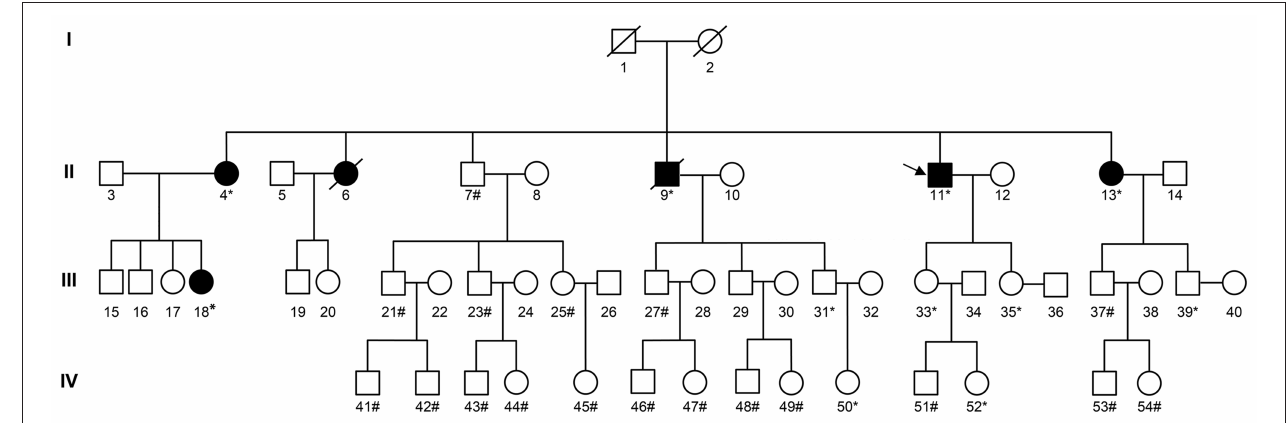
FIGURE 4 | Pedigree of the family with MSH2 c.1024_1026. The arrow ( → ) indicates the proband. Squares and circles denote males and females, respectively. Roman numerals indicate generations. Black solids represent tumor patients. Patients number 4, 6, 13, and 18 suffered from endometrial carcinoma before the age of 50. Furthermore, patient number 4 also suffered from rectal carcinoma at the age of 52. Patient number 9 suffered from gastric carcinoma at the age of 60. Patient number 11 suffered from renal carcinoma at the age of 41, skin carcinoma at the age of 53, and a rectal neuroendocrine tumor at the age of 58. The asterisk (*) indicates MSH2 c.1024_1026 carriers. The pound (#) indicates non-carriers. The remaining family members have not been tested for MSH2